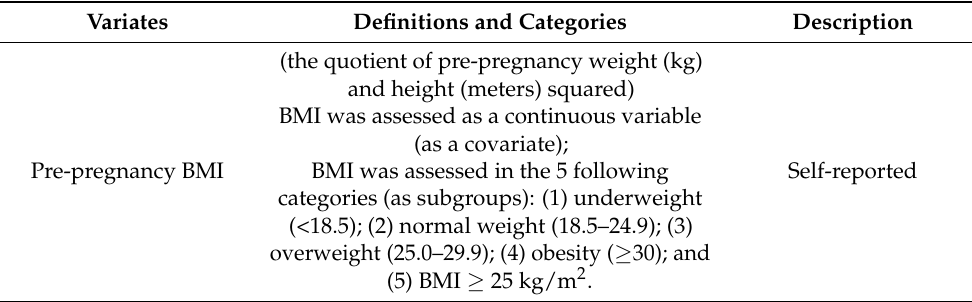
Table 1. Characteristics of the covariates and main dependent